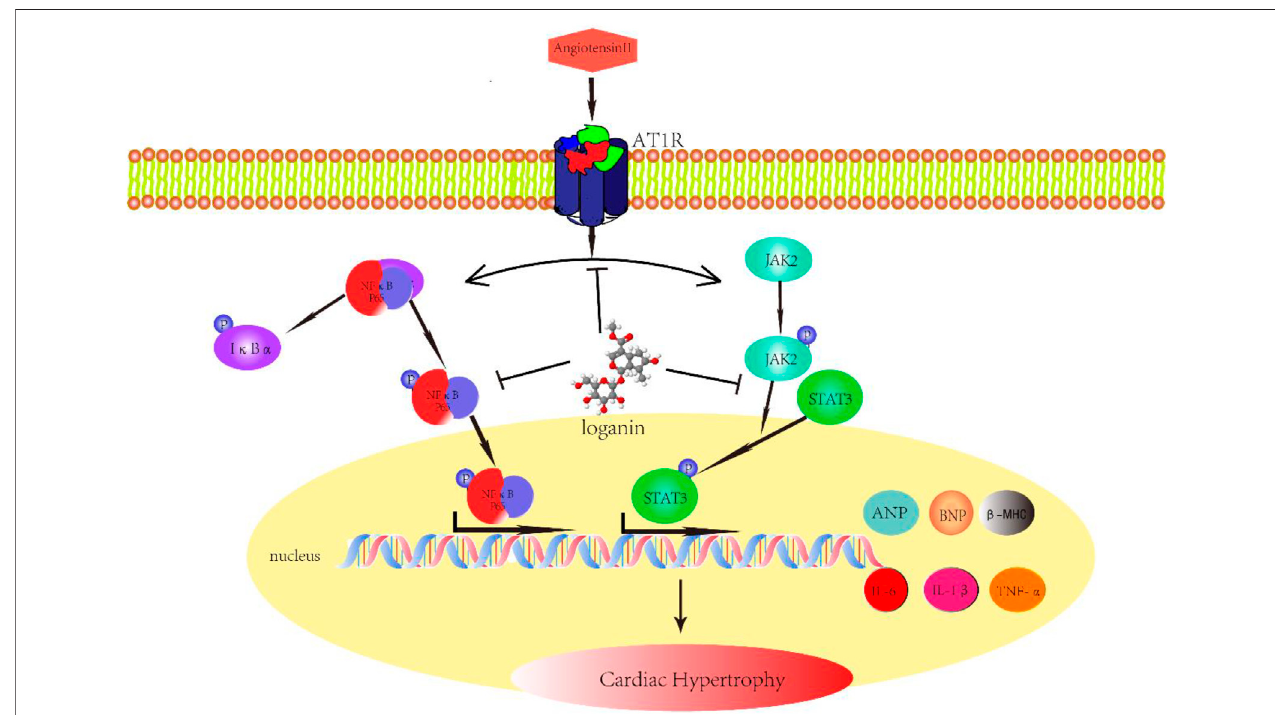
FIGURE 6 | Schematic diagram with roles of loganin in Ang II – induced cardiac hypertrophy. Angiotensin II (Ang II) can induce cardiac hypertrophy in vivo and in vitro , which is mainly mediated through angiotensin II type 1 receptor (AT1R). Given Ang II stimulation, in addition to the increase in IL-1 β , IL-6, and TNF- α secretion, ANP, BNP, and β -MHC expressions are also augmented. Loganin ameliorates Ang II – provoked cardiac hypertrophy and cardiac damage through suppressing the JAK2/STAT3 and NF- κ B signaling pathways.